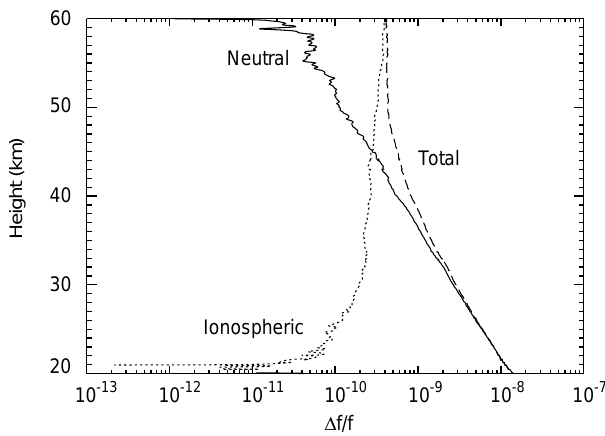
Fig. 2. Doppler shift (without vacuum Doppler shift) as function of height for one occultation event (0031-05.17-95.298). The solid line is the Doppler shift caused by the refraction of the neutral atmosphere, the dotted line is the Doppler shift caused by the ionosphere and the dashed line is the total measured Doppler shift. Below 30 km height the ionospheric contribution to the Doppler shift is 1-2 magnitudes less than the